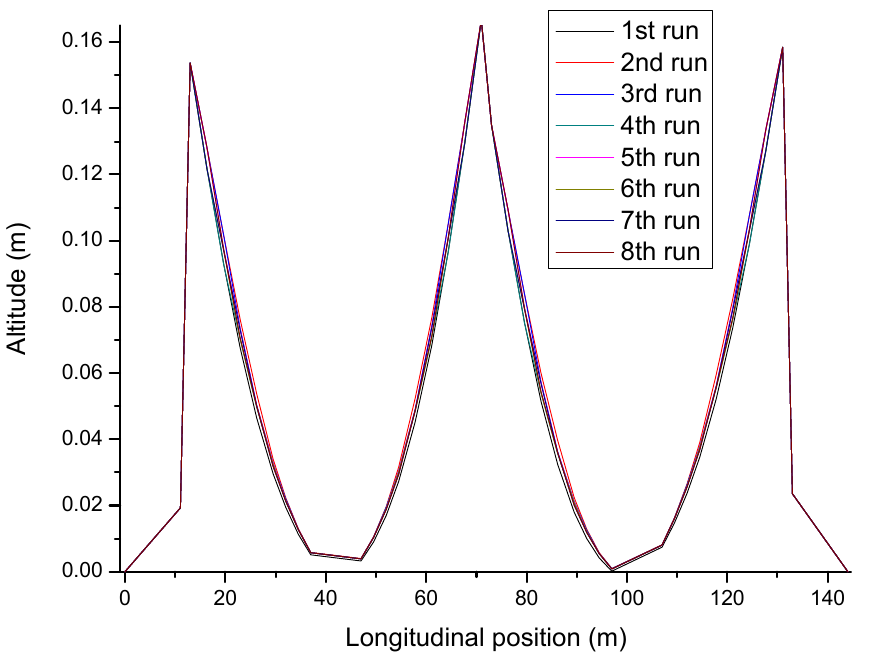
20 of 22 Table A1. Sample points based on seven ‐ factor two ‐ level orthogonal experimental design. Run